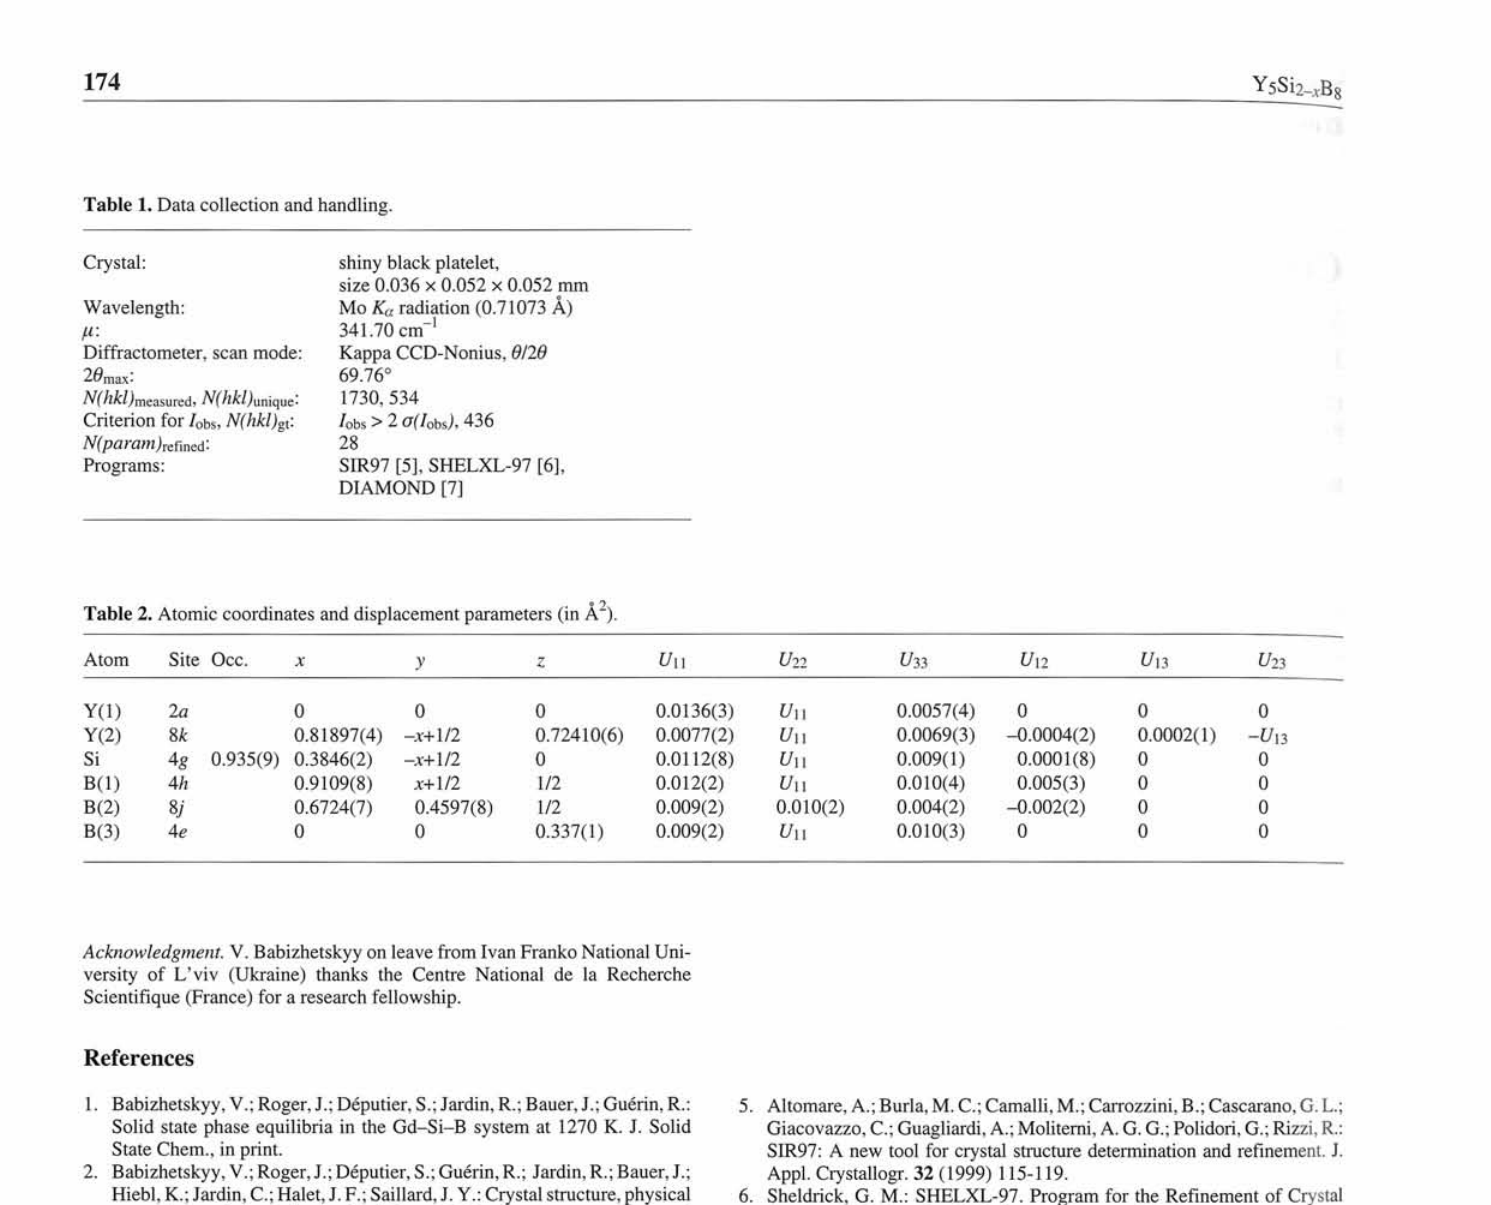
Table 1. Data collection and handling.